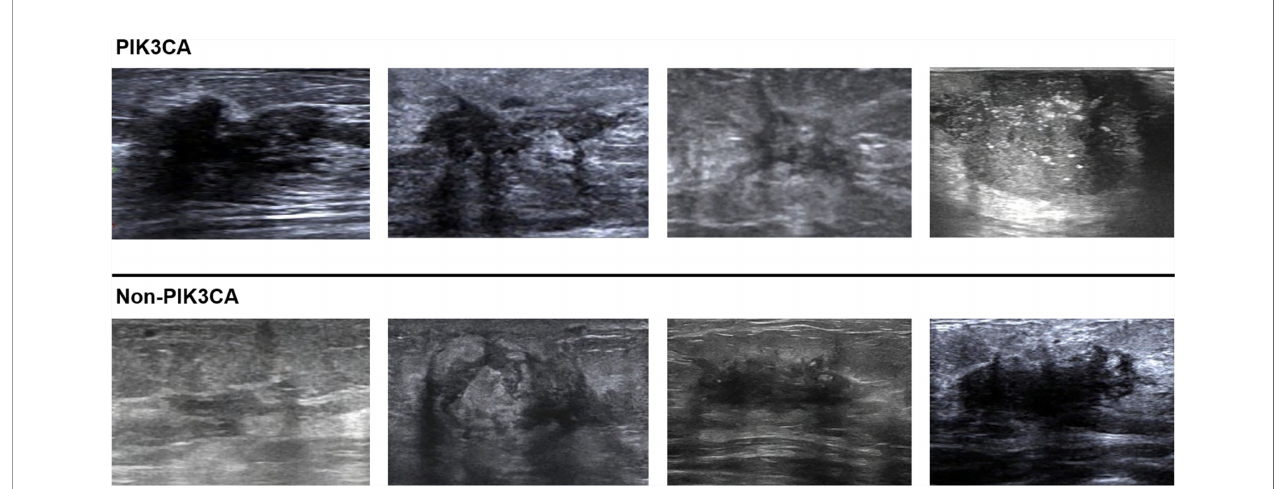
FIGURE 6 | Classi fi cation examples of the ImResNet